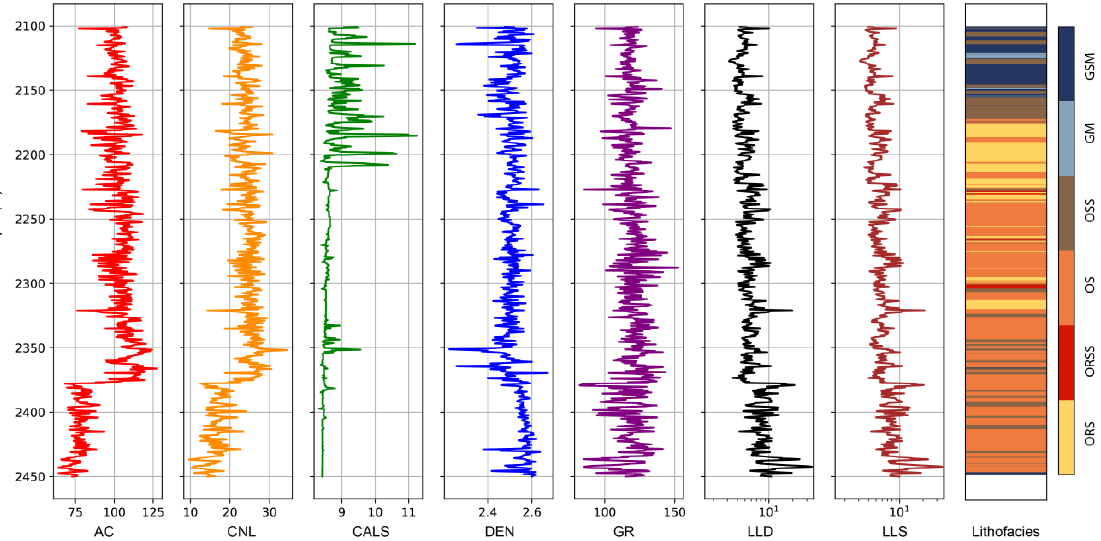
Figure 6. Integrated well logs and lithofacies model of the Qingshankou Formation in one of the training wells. Shale lithofacies were classified using elemental capture spectroscopy logs (ECS) and measured TOC data. See the text for abbreviations of lithofacies and well logs.